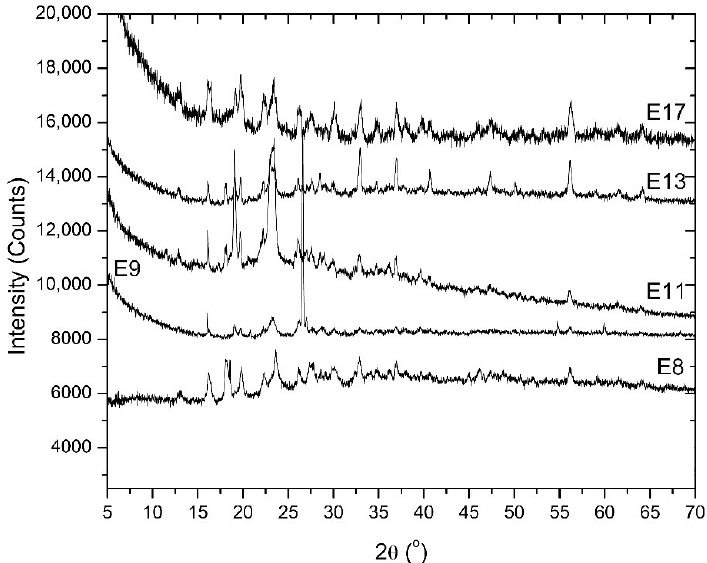
Figure 8. Comparison plot of the X-ray diffraction data collected for the dust samples collected for E8, E9, E11, E13, and E17. Patterns are shifted for clarity, and E17 is enhanced by a factor of 4 to allow comparisons.